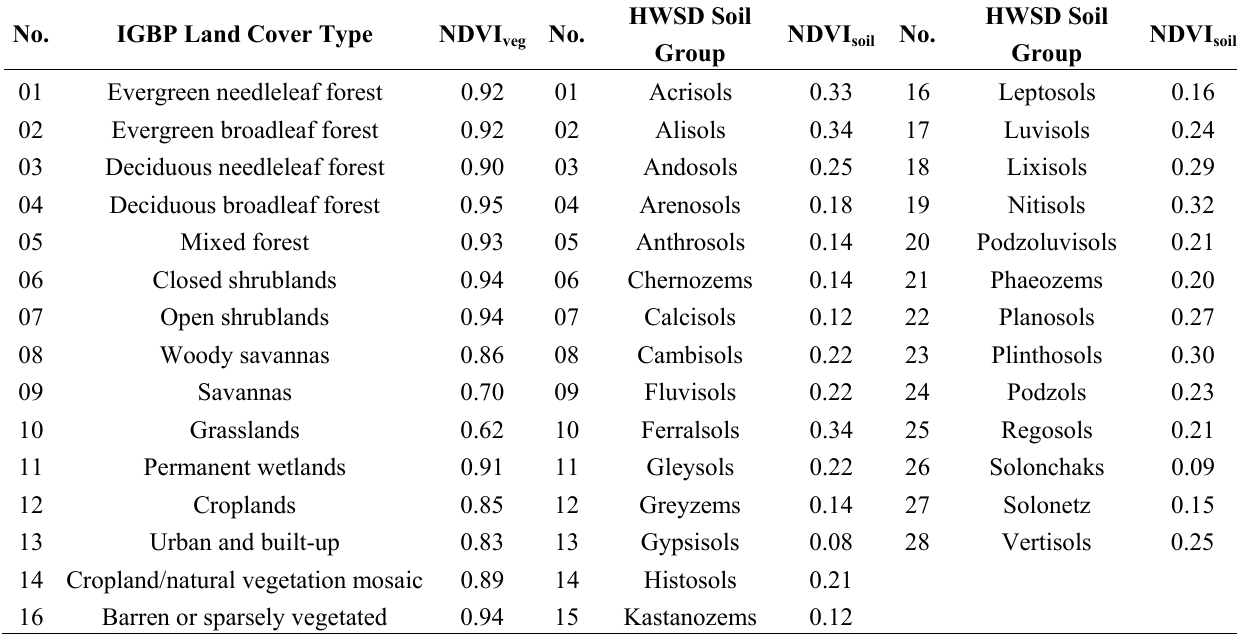
and NDVI used in this vegi soilj